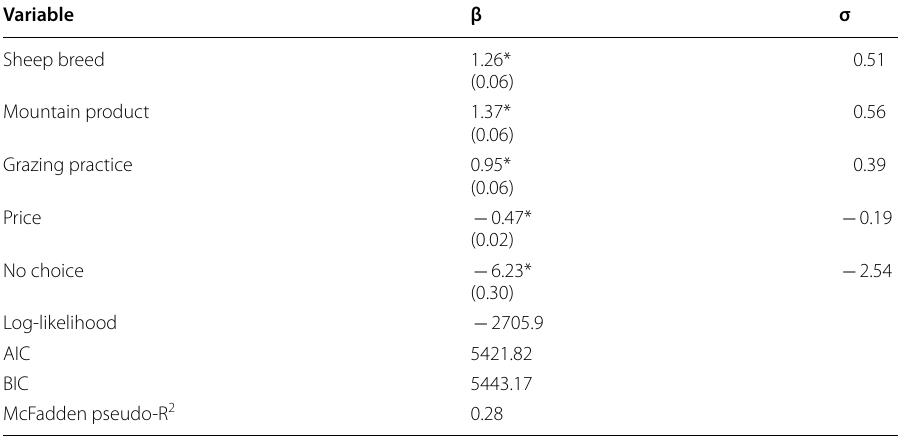
Table 4 Estimated parameters and standard deviations from the RPL model, standard errors in